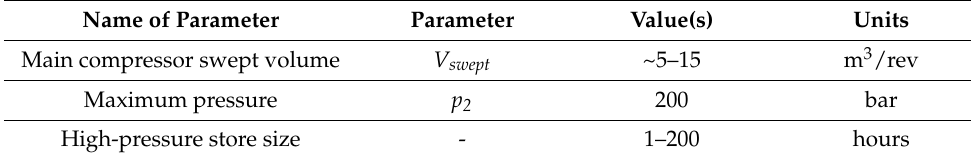
Table 2. System parameters for Wi-DACIS